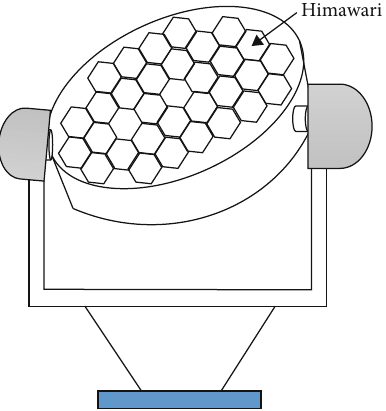
Figure 8: Himawari solar lighting system (source: adapted from [57]).